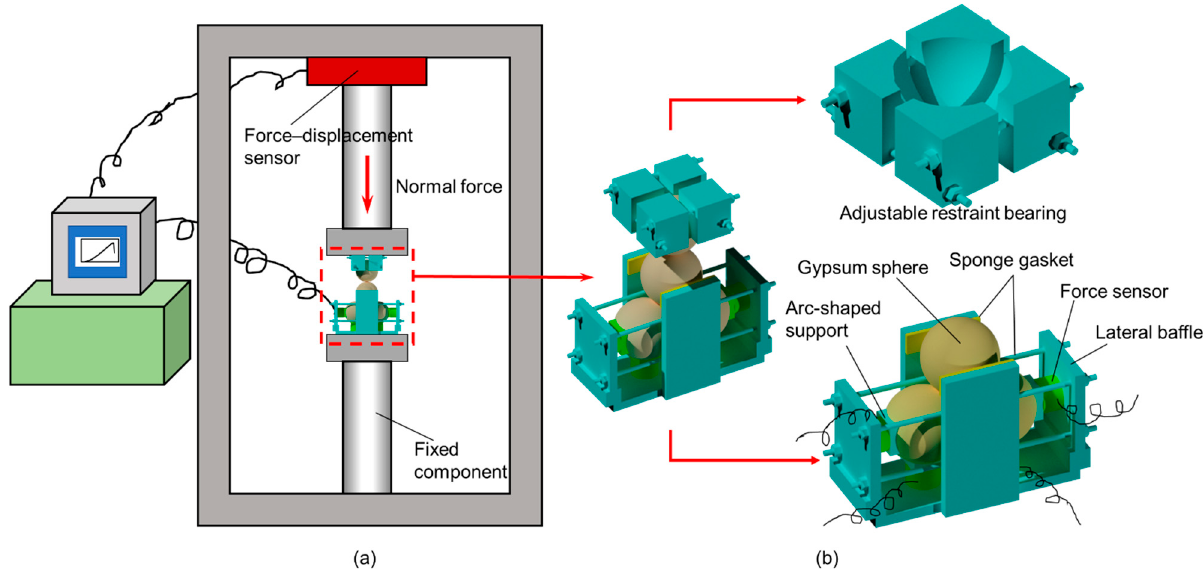
Figure 7. Some of the apparatuses used were as follows: ( a ) the rock rheological testing system and ( b ) the self-developed fixture. The restraint bearing can be adapted to spheres with different particle sizes by adjusting its size. All arc-shaped supports and force sensors are movable. The distance between the two lateral baffles can be adjusted freely. The front and rear baffles are used to assist in fixing the position of Particle I and do not exert forces on the sphere.